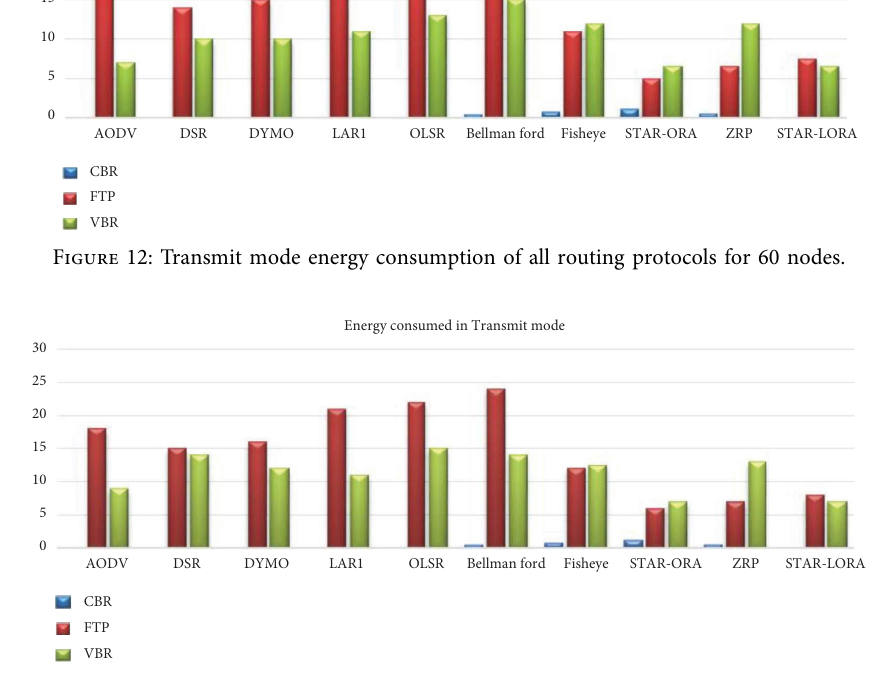
Figure 13: Transmit mode energy consumption of all routing protocols for 120